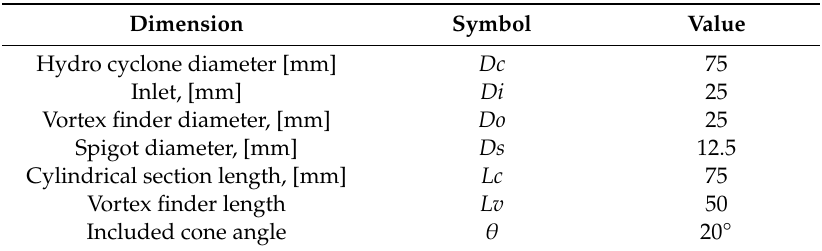
Table 1. Dimension of Hsieh hydrocyclone.